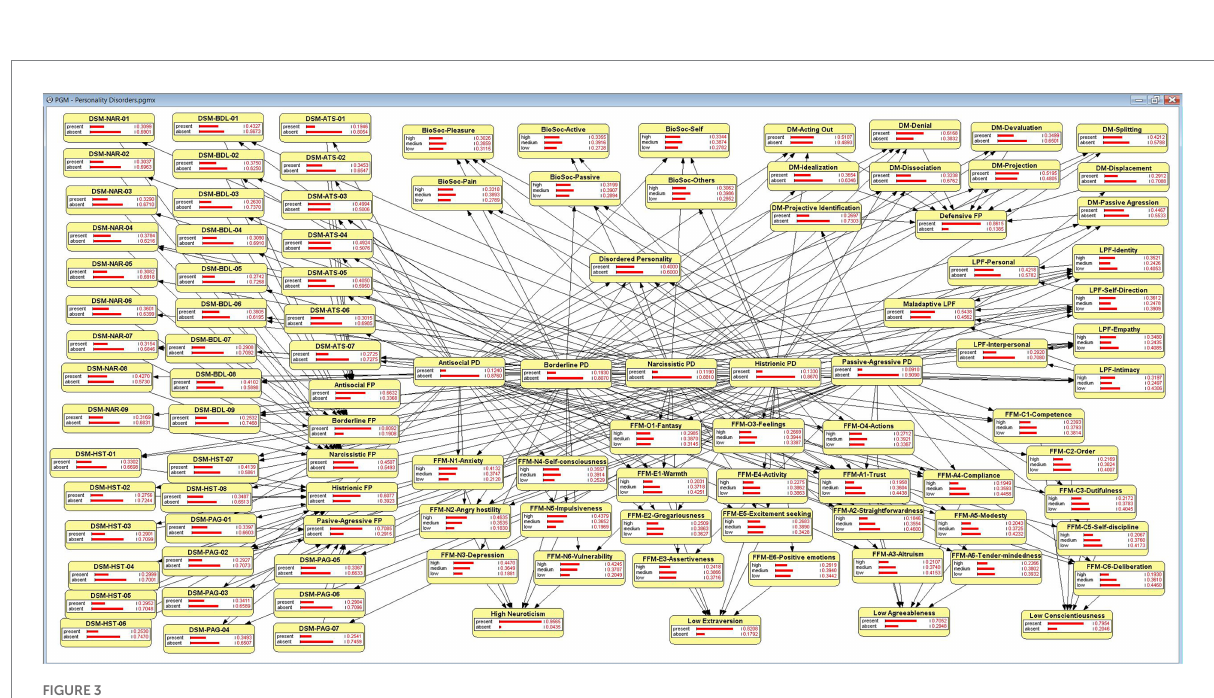
FIGURE 3 The Bayesian network, in OpenMarkov’s inference